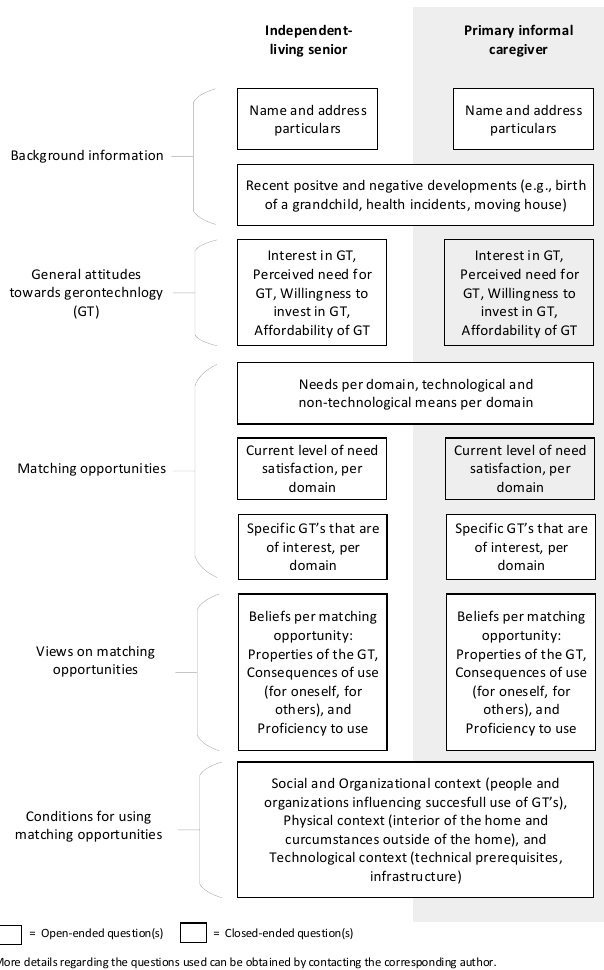
Figure 1. Gerontechnologies Matchmaking (GTM) tool [52] .